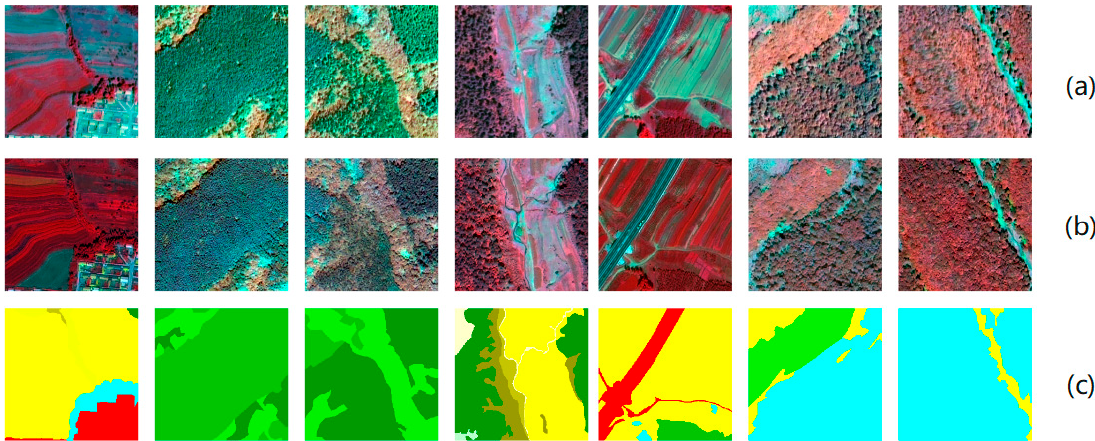
Figure 2. Examples in detail for some of the training samples in the Wangyedian forest farm. ( a ) Original image blocks of 2019 (bands 4, 3, 2 false-color combinations); ( b ) original image blocks of 2017 (bands 4, 3, 2 false-color combinations); ( c ) ground truth (GT) blocks showing the labels corresponding to the image blocks in ( a ) and ( b ).